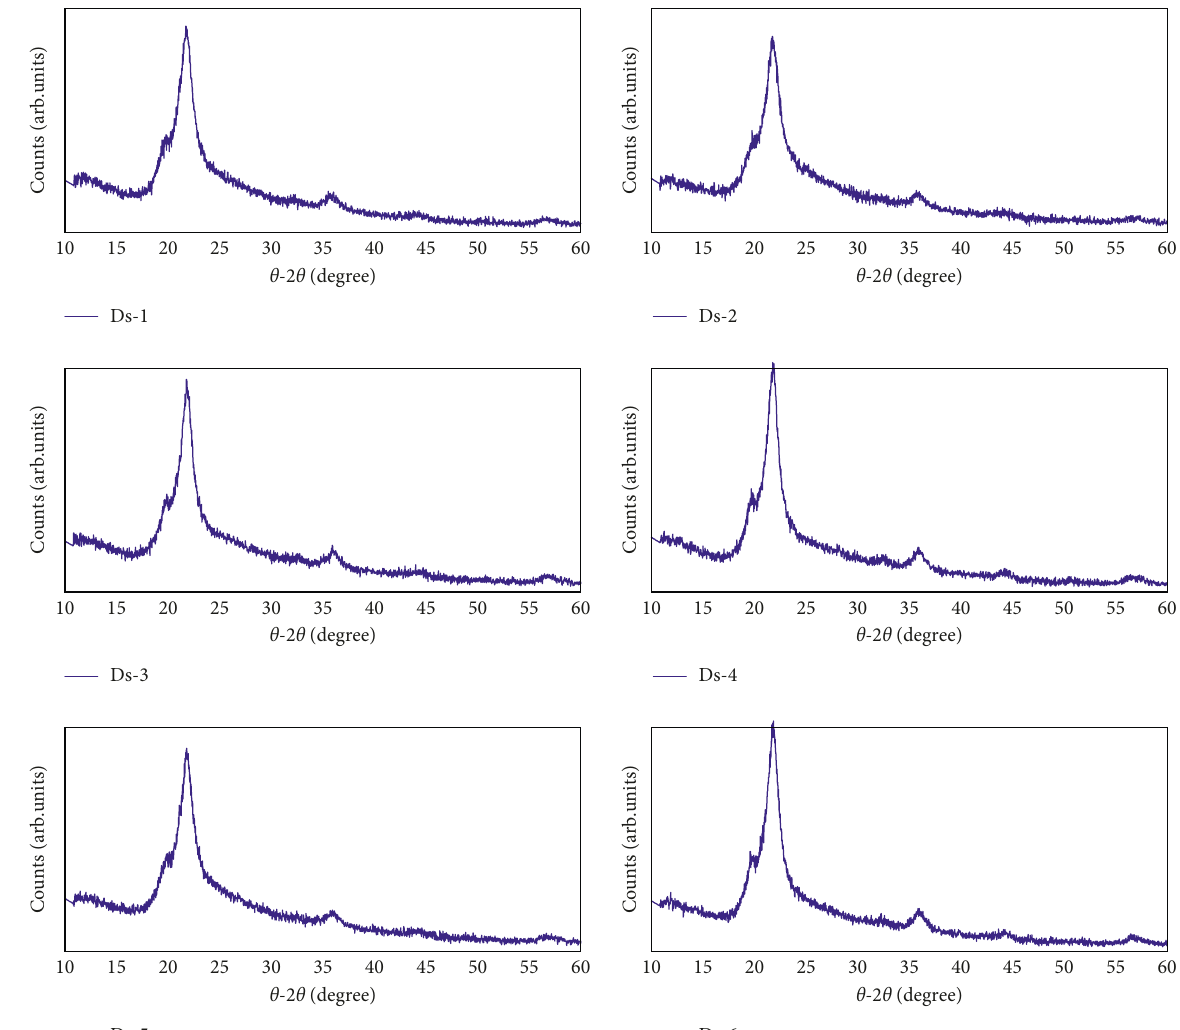
Figure 4: XRD diffraction patterns of opal samples mined from different geological localities of Delanta.